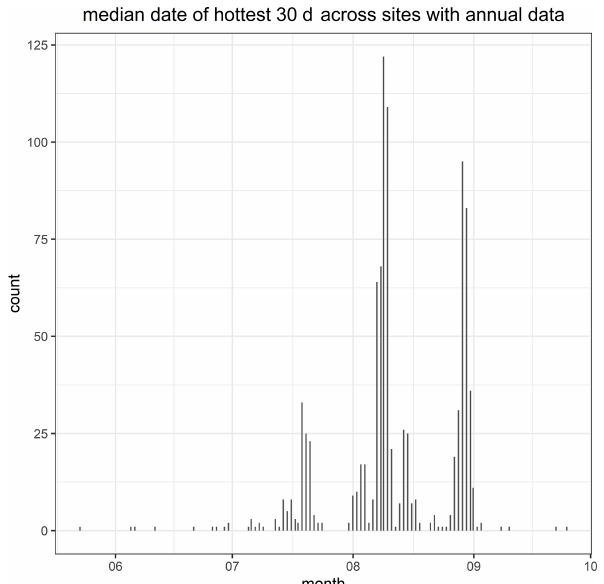
Figure B2. Daily lags for T air that produce the highest R 2 (colors) for a regression between T w and a right-aligned moving average of T air at each site as a function of watershed area. The moving average lag whose regression produced the highest R 2 was used to fill gaps in the time series of T w for each station. Each point represents a sta- tion, with the x axis being the watershed area at that station and the y axis being the lag in T air that produced the best regression. Points are jittered for visual clarity; only integer lag values were possible. Black points indicate the mean and standard error (horizontal bars) of watershed areas within each possible lag (2–10d).